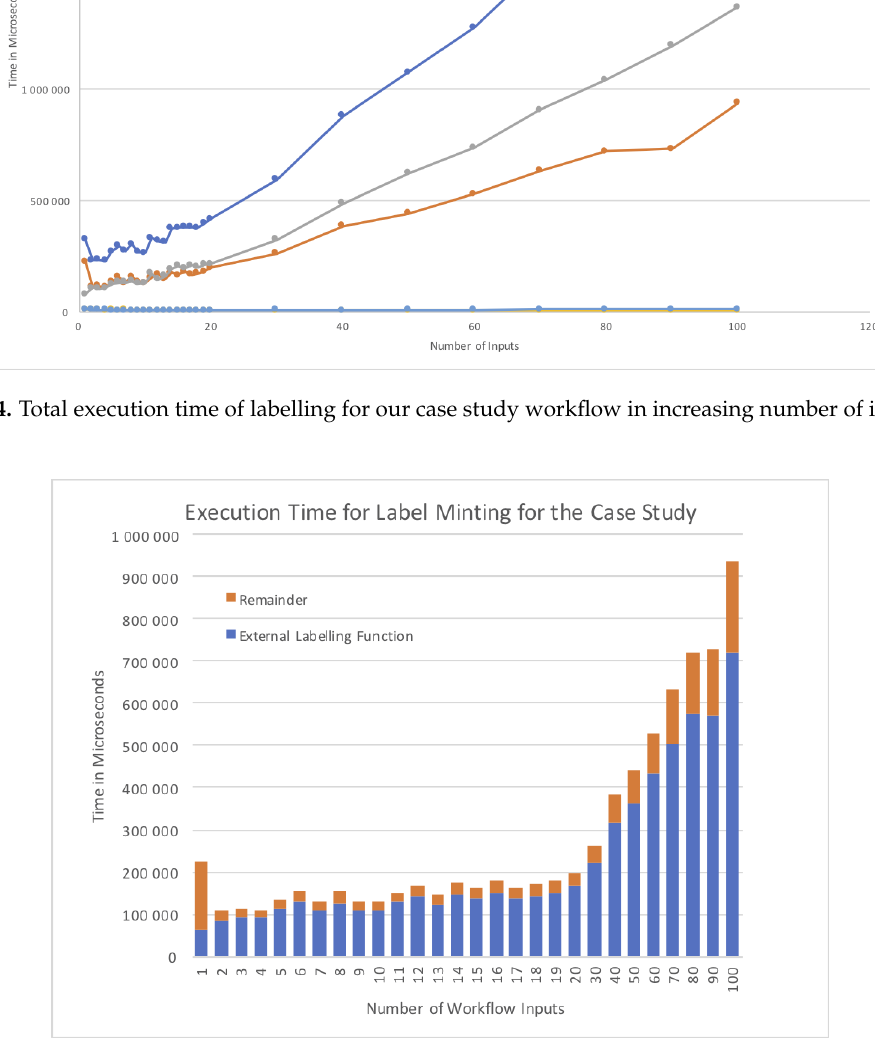
Figure 15. Percentage of the time taken by external Mint function within the total time taken by the Mint